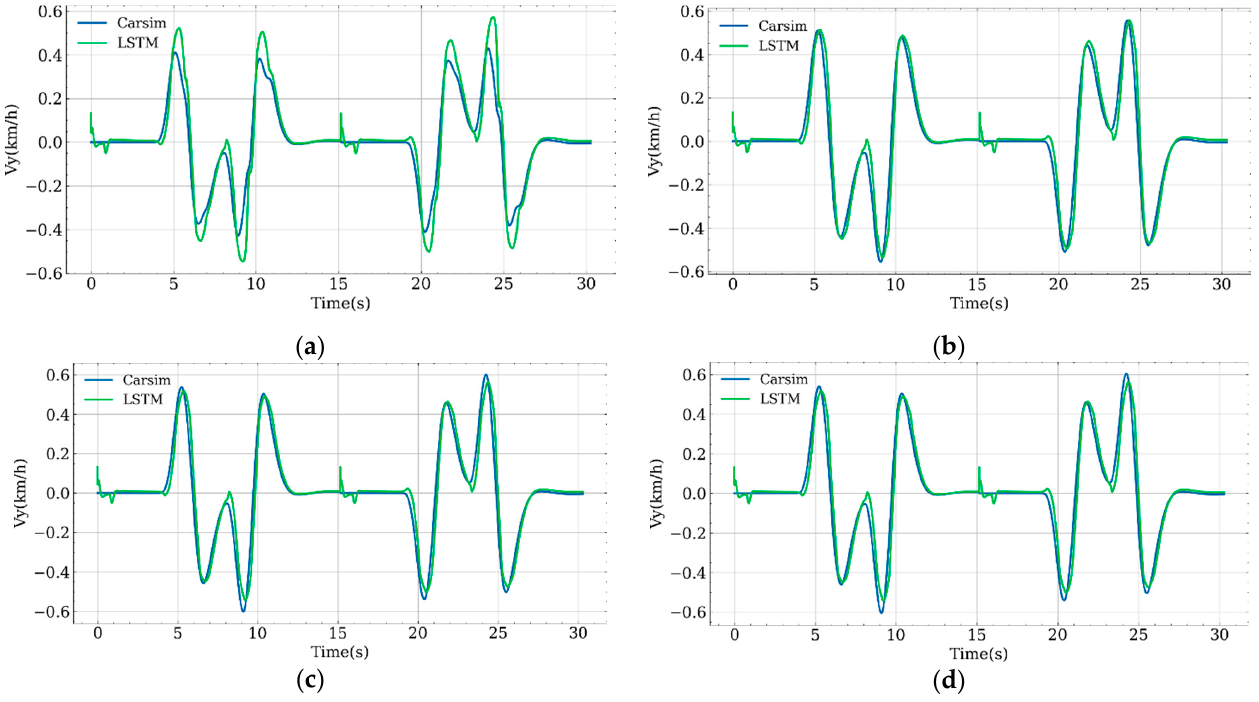
Figure 7. Estimation Results under 50 km/h DLC condition: ( a ) road friction coefficient of 0.3; ( b ) road friction coefficient of 0.5; ( c ) road friction coefficient of 0.85; ( d ) road friction coefficient of 1.0.